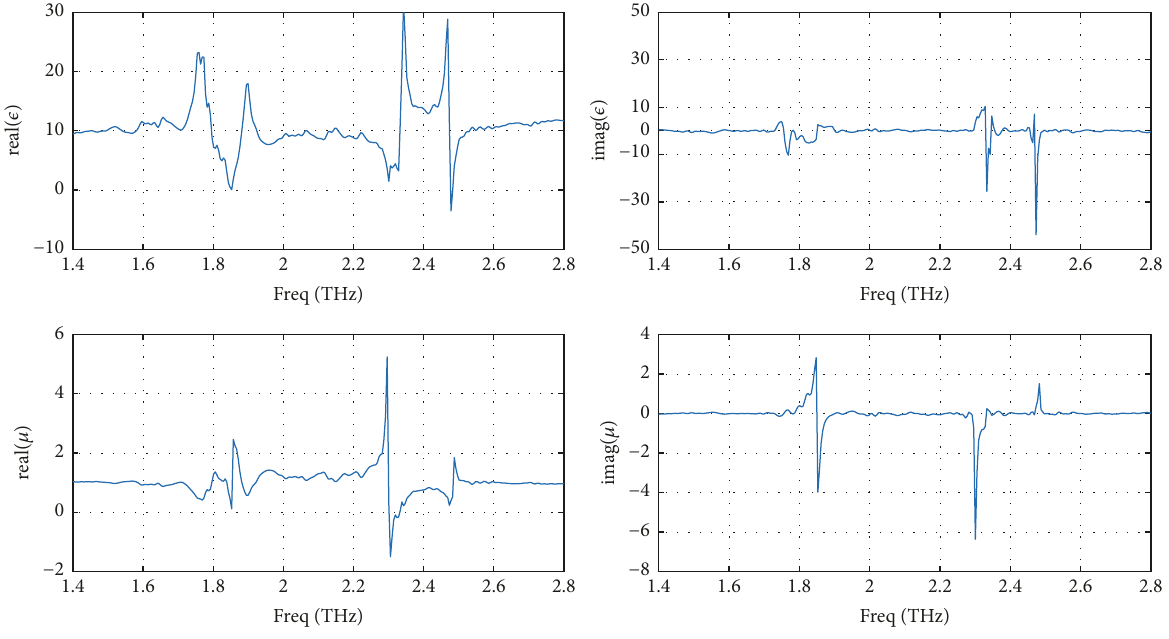
Figure 12: The effective permittivity and permeability for photonic crystal.